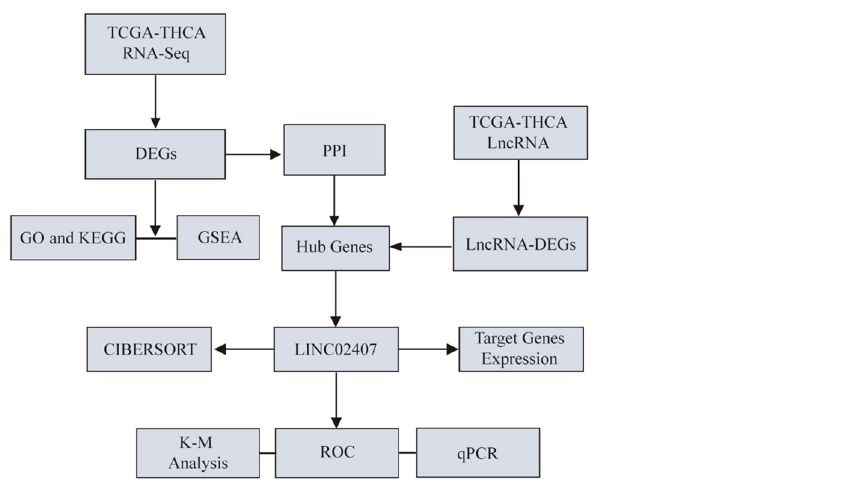
Figure 10. overview of the